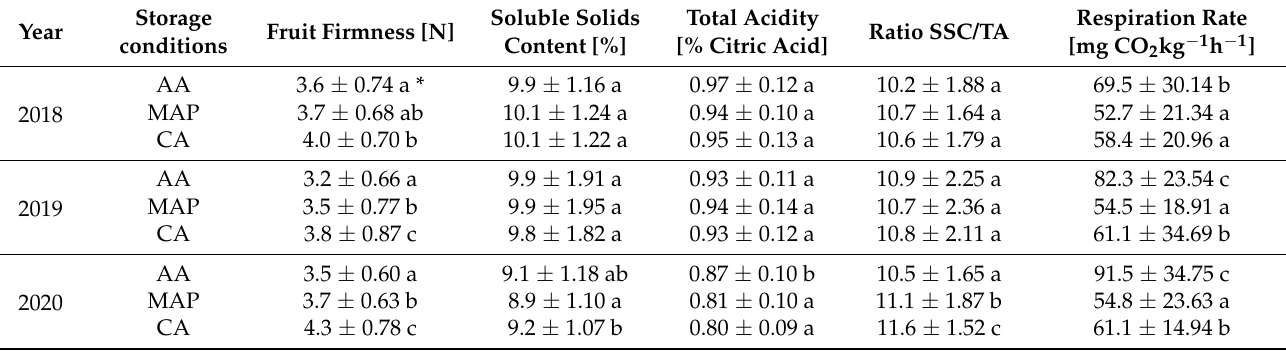
Table 5. Effect of storage conditions on the quality of ‘Albion’ strawberries and average for harvest dates.